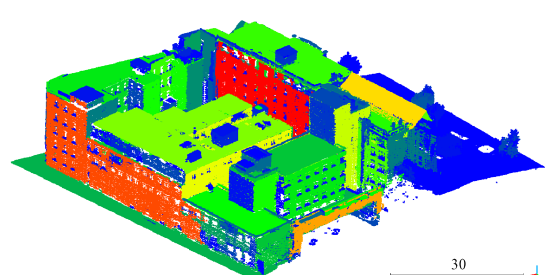
Figure 1. Clustering output for the training set of the Dublin